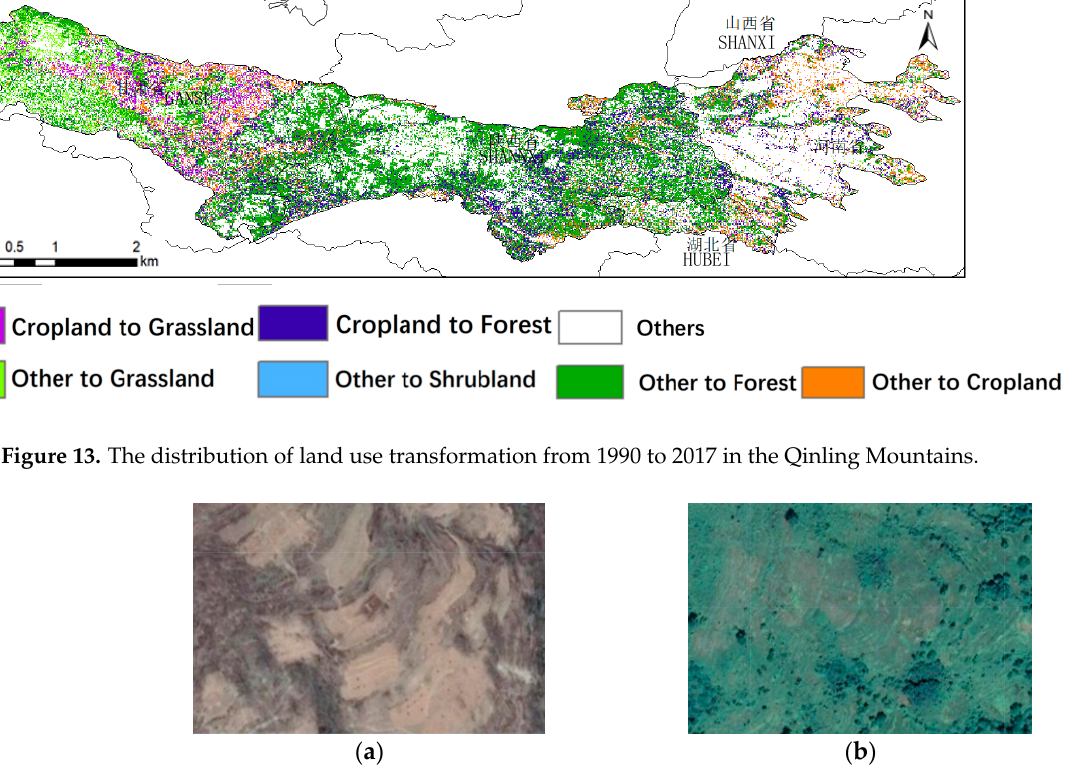
Figure 14. The comparison figure of vegetation cover change before and after “Grain For Green” project (which obtained from the Google image). ( a ) Before “Grain For Green” project. ( b ) After “Grain For Green” project.